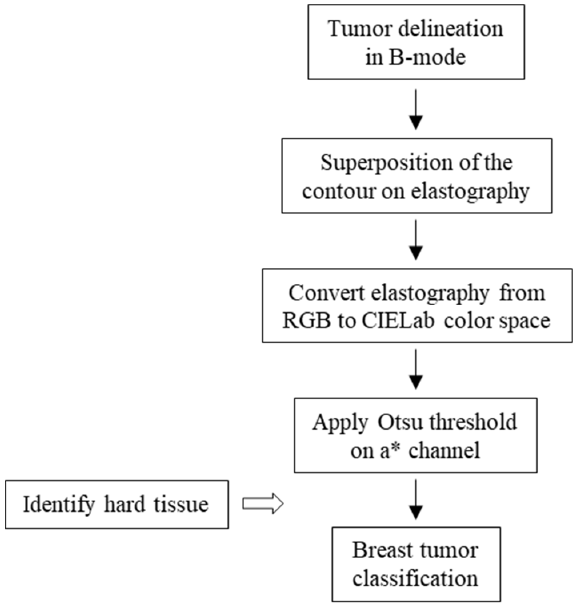
Figure 3. Computer-aided diagnosis system for breast tumor classification.